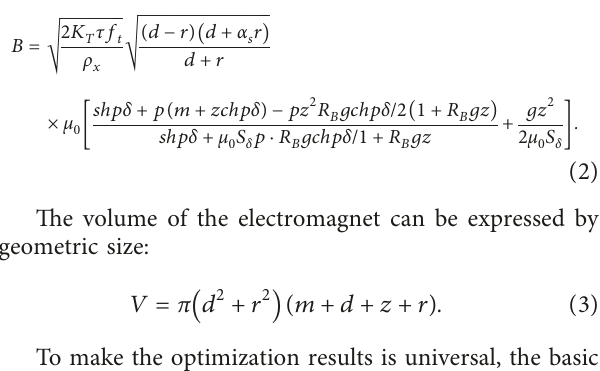
Figure 1: Structural sketch of DC solenoid